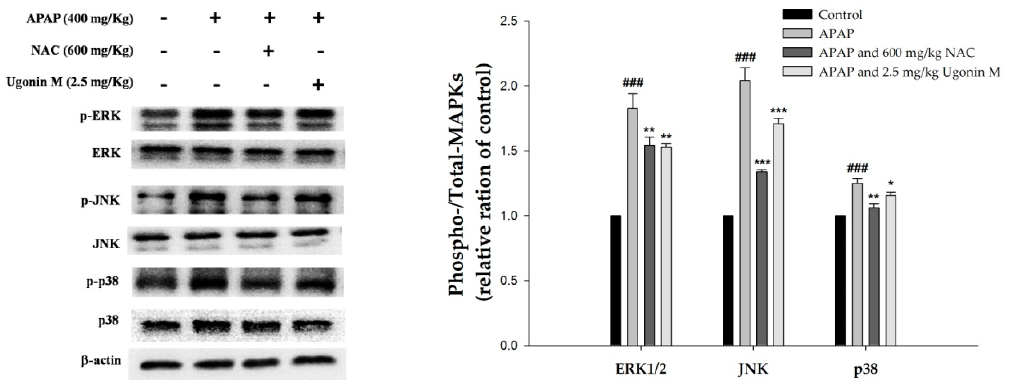
Figure 9. Effects of Ugonin M on APAP-induced mitogen-activated protein kinase (MAPK) phosphorylation and non-phosphorylation protein expression concentration in liver tissue. Data are expressed as M ± SD; n = 3